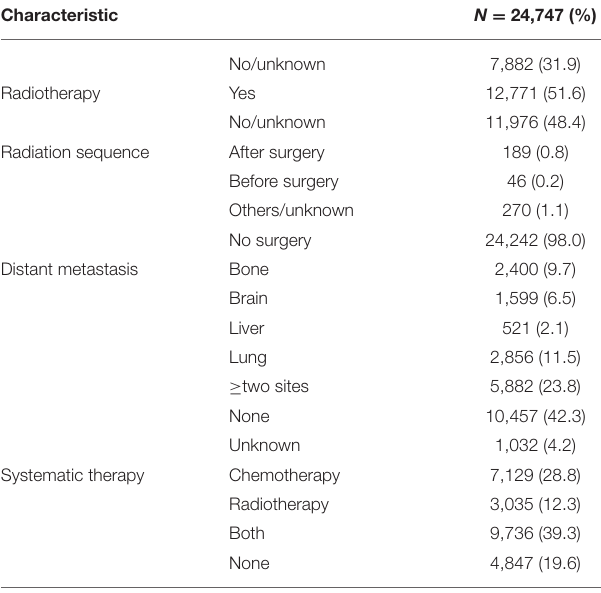
TABLE 1 | Demographic characteristics of N3-NSCLC